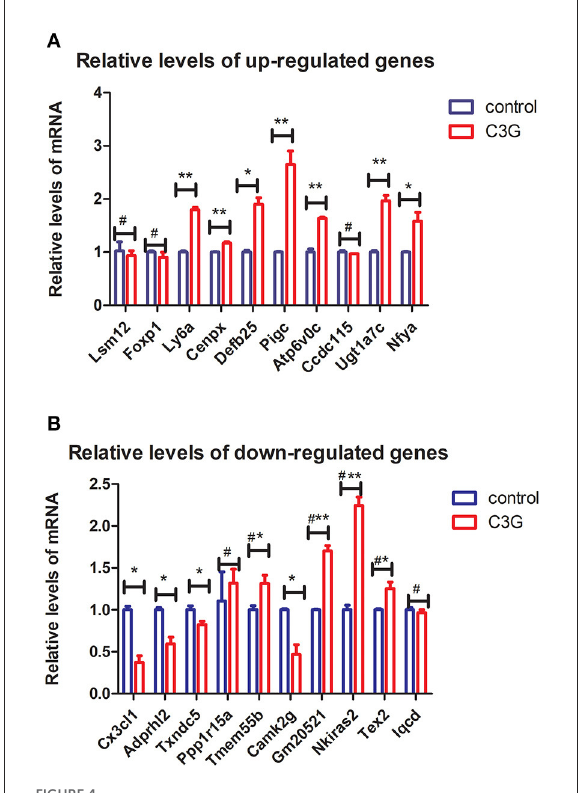
FIGURE4 qRT-PCR validation of top DEGs. (A,B) Expression levels of top 10 upregulated (A) and downregulated (B) DEGs evaluated